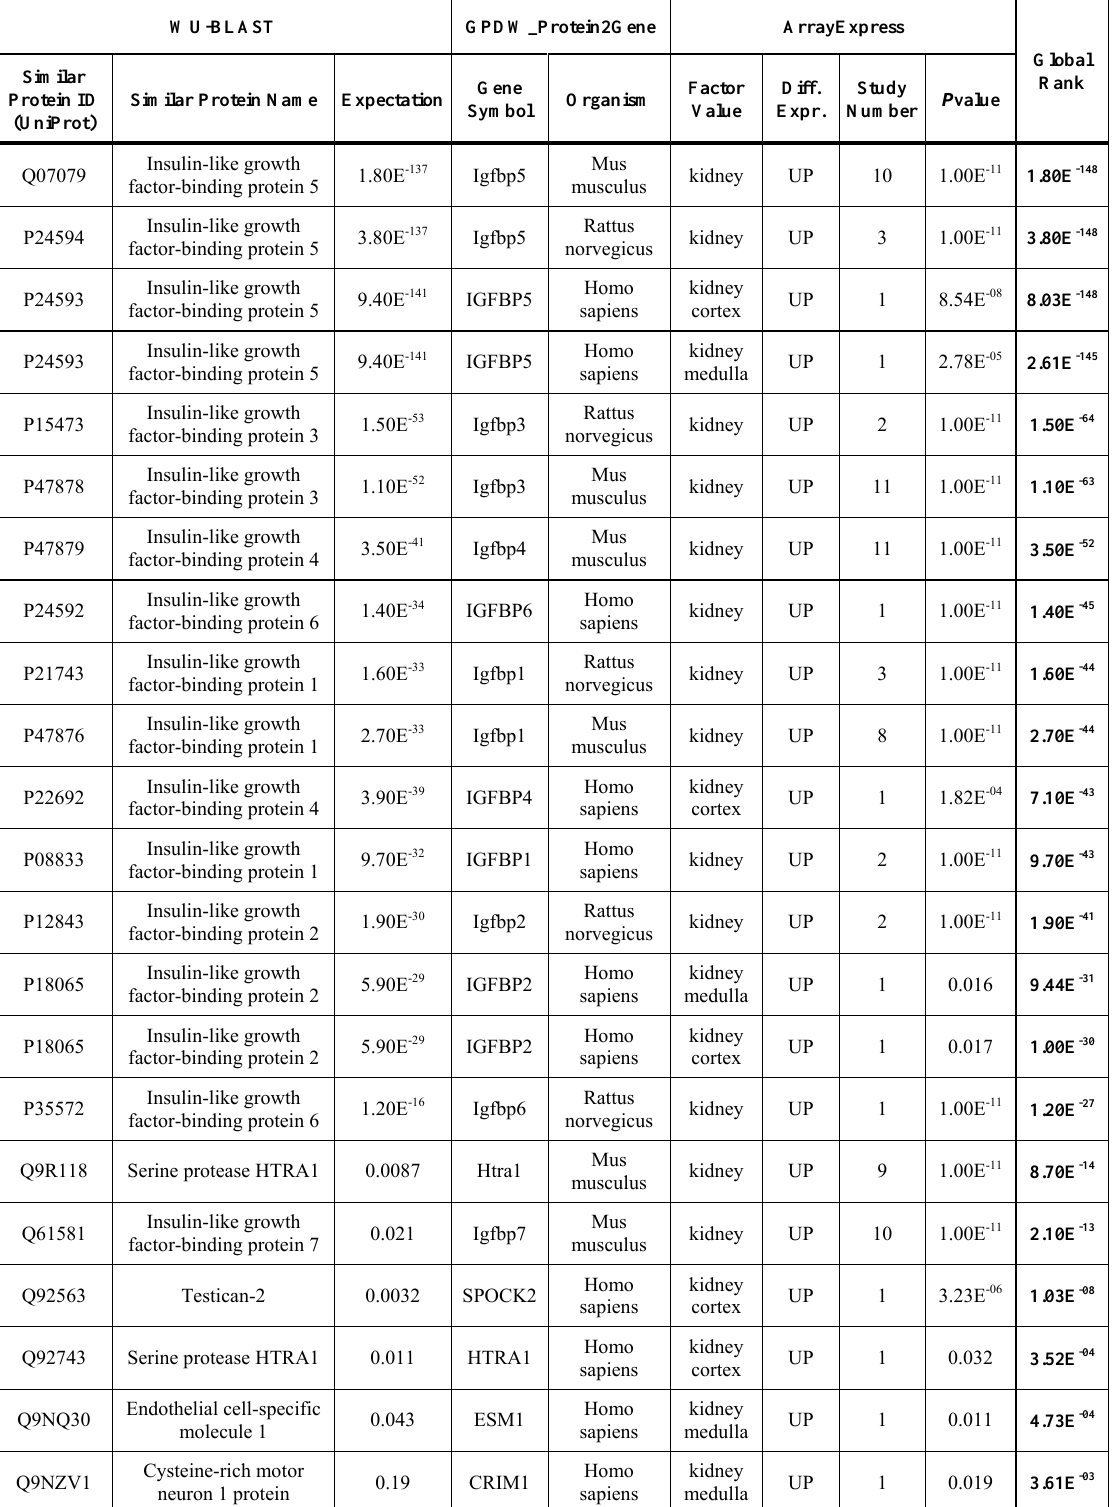
Table 1: Global ranked results provided by search computing to the case study question for the user input QuerySequenceID = “ uniprot:P24593 ”, ExpressionRegulation = “ up ” and Condition = “ kidney ”. Expectation: BLAST expectation value; Diff. Expr.: gene differential expression type; for all table items, ArrayExpress Experimental Factor = “Organism part” (not